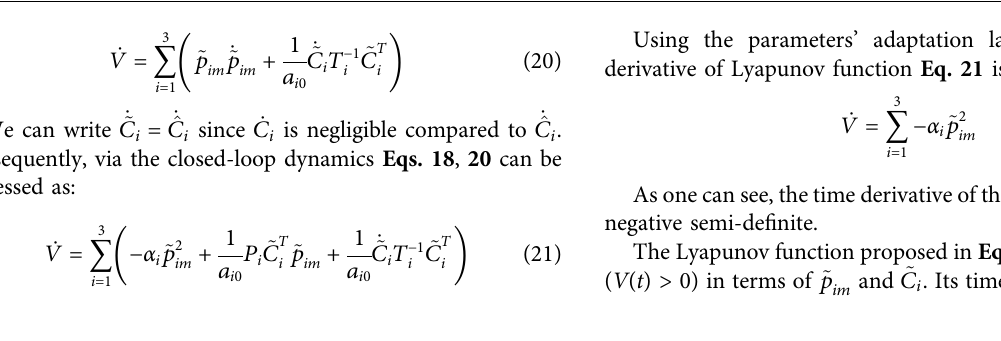
Frontiers in Robotics and AI |